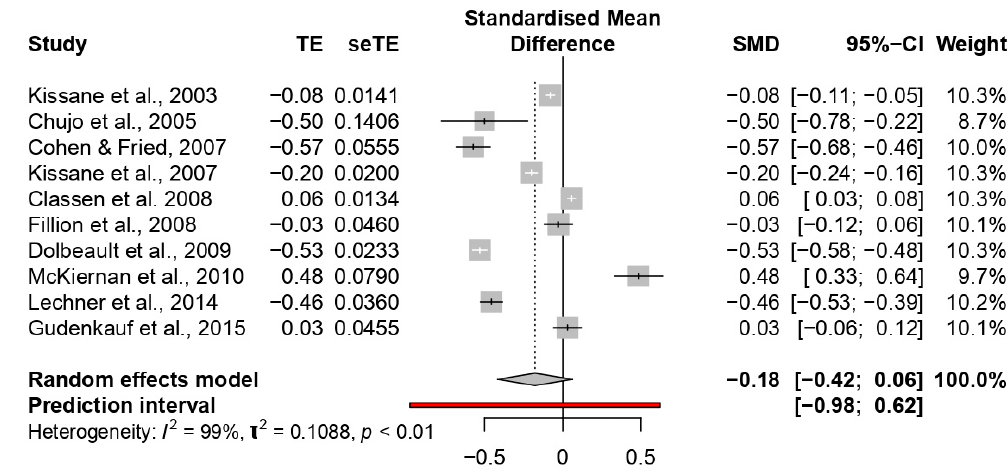
Figure 5. Forest plot of the studies considering psychological interventions focused on increasing mood.